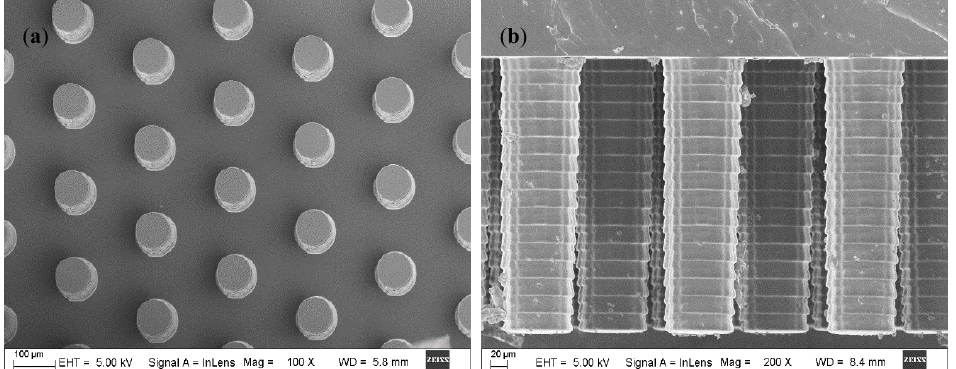
Figure 3. The fabrication process of the μ EDS. ( a , b ): fabrication of the negative PDMS masters of μ AE and microchannel; ( c , d ): fabrication of the μ AE and microchannel; ( e ): deposition of the conducting layer; ( f , g ): oxygen plasma treatment; ( h ): integration of the detection microchip.